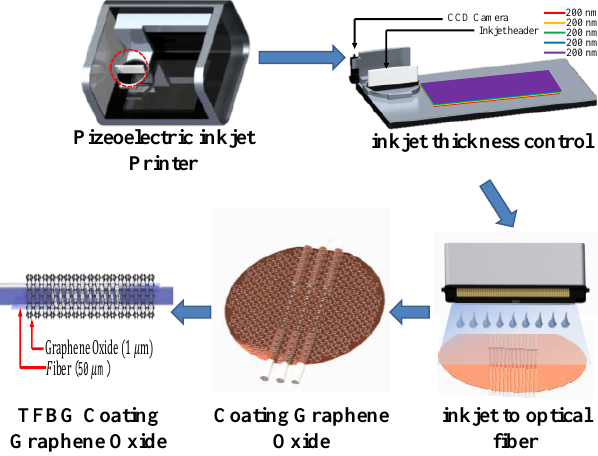
Figure 3. Flow chart of the process of using piezoelectric inkjet technology to coat the fiber with graphene oxide.